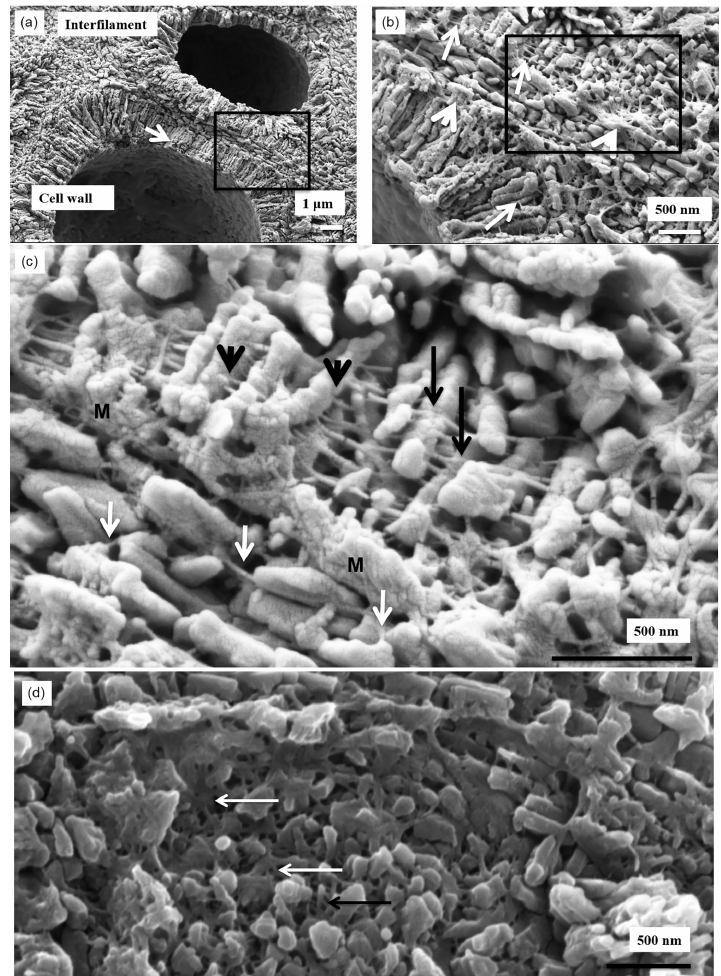
Figure 7. K. epilaeve cell wall structure. Crust polished and cleaned for 2min. (a) Cell walls have radial Mg-calcite, whereas the interfilament grains are orientated either parallel to the filament axis or randomly within the corner junctions. Within the radial cell walls a secondary concentric banding pattern is visible (white arrow). Black box enlarged in (b) . (b) Organic fibrils, ∼ 10nm wide, run parallel to cell wall edges (black arrows). Fibrils are concentrated along the outer of the cell wall (white arrows). Black box enlarged in (c) . (c) The cell wall fibrils appear to string through the centre of the radial grains (black arrowheads); other fibrils drape over the grains (black arrows). Fibrils are present in the interfilament (white arrows). M – mineralised membrane. (d) Plan view of cell wall grains. Organic fibrils form a dense mesh (white